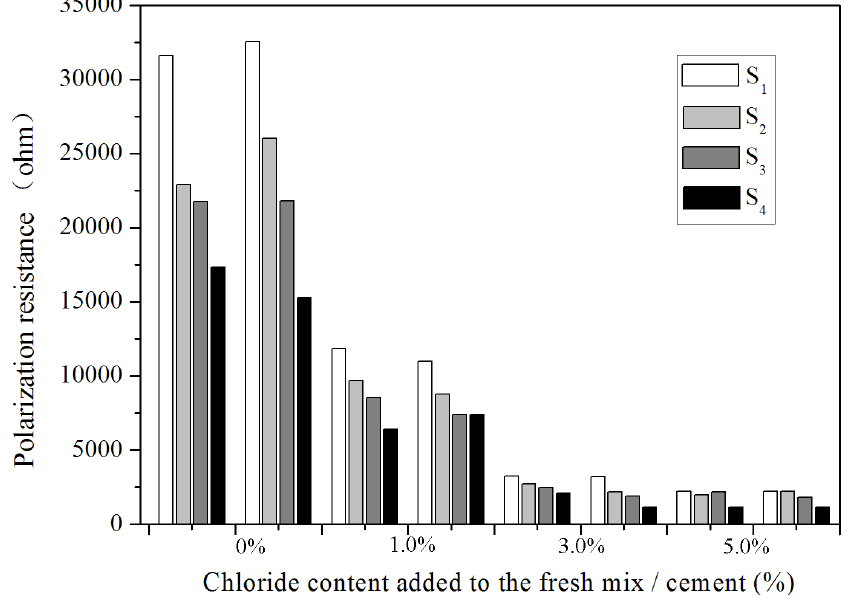
Figure 6. R results from LPR tests of corrosion sensors in cement mortar samples with p different chloride contents ( A to D